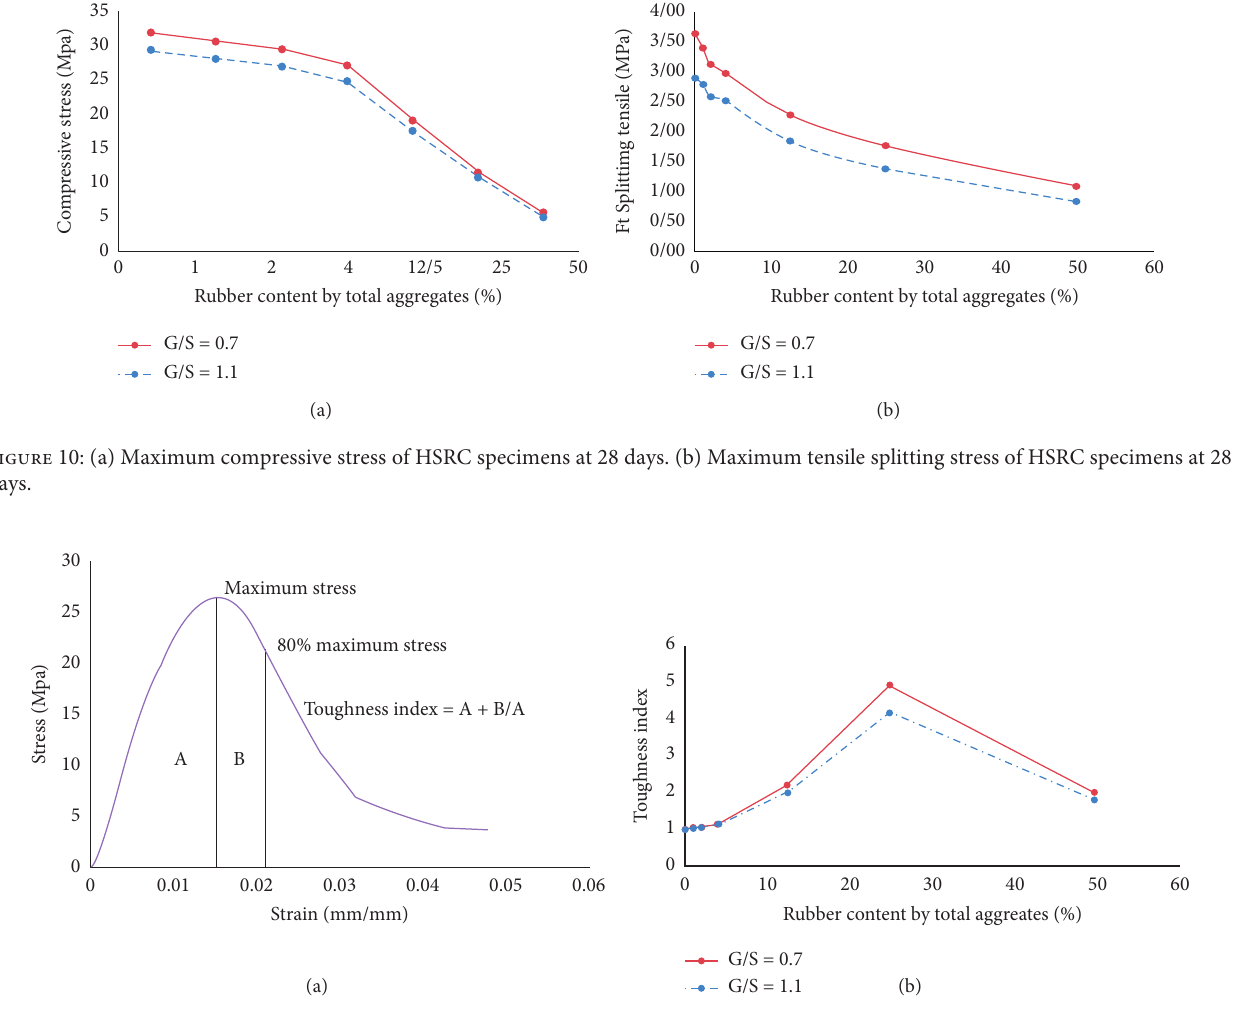
Figure 11: (a) Evaluation of toughness index. (b) The toughness index value for HSRC specimens at 28 days.